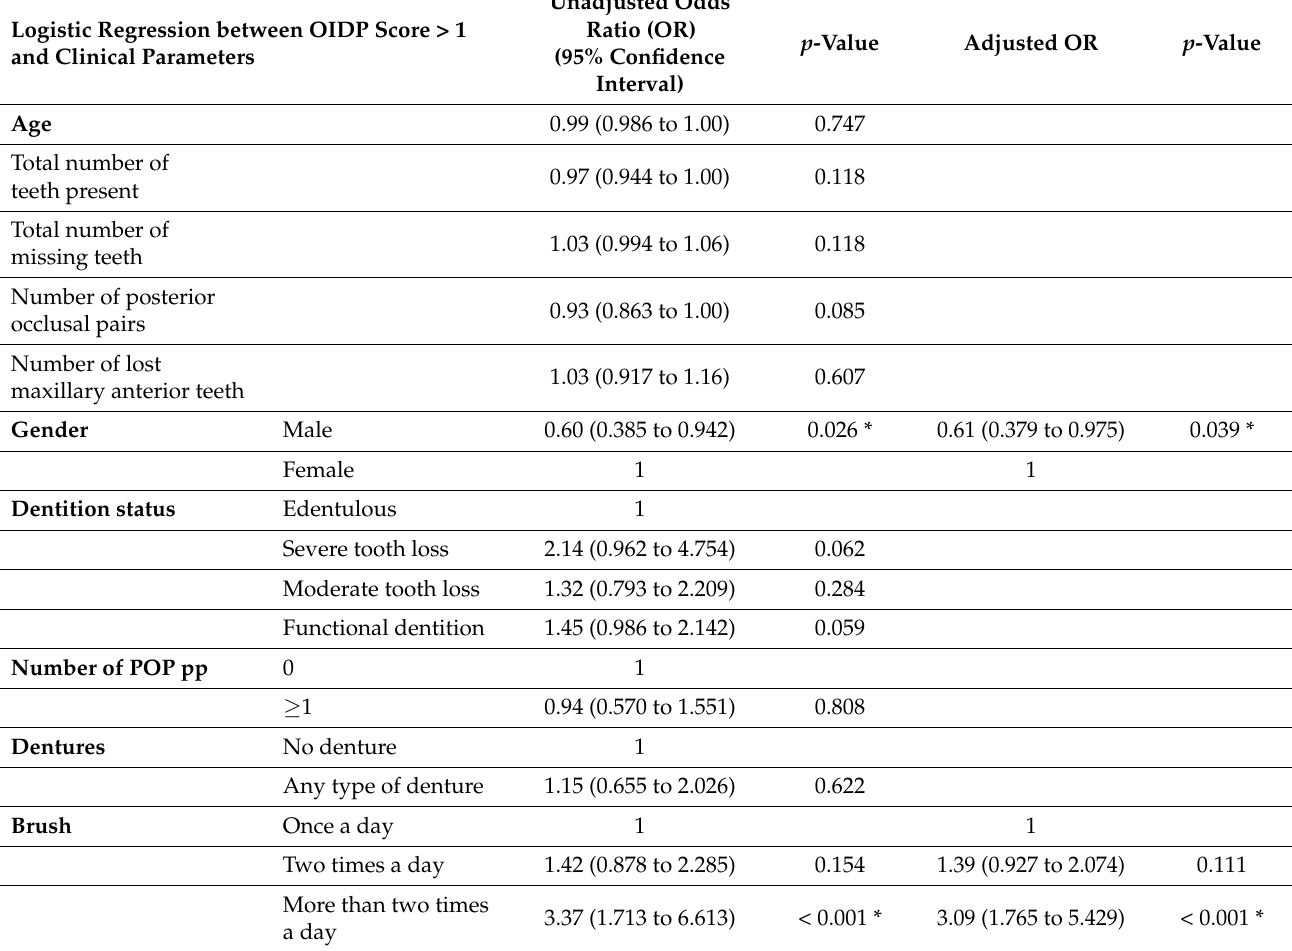
Table 3. The logistic regression for OIDP scores with clinical parameters (OR with 95% confidence intervals).